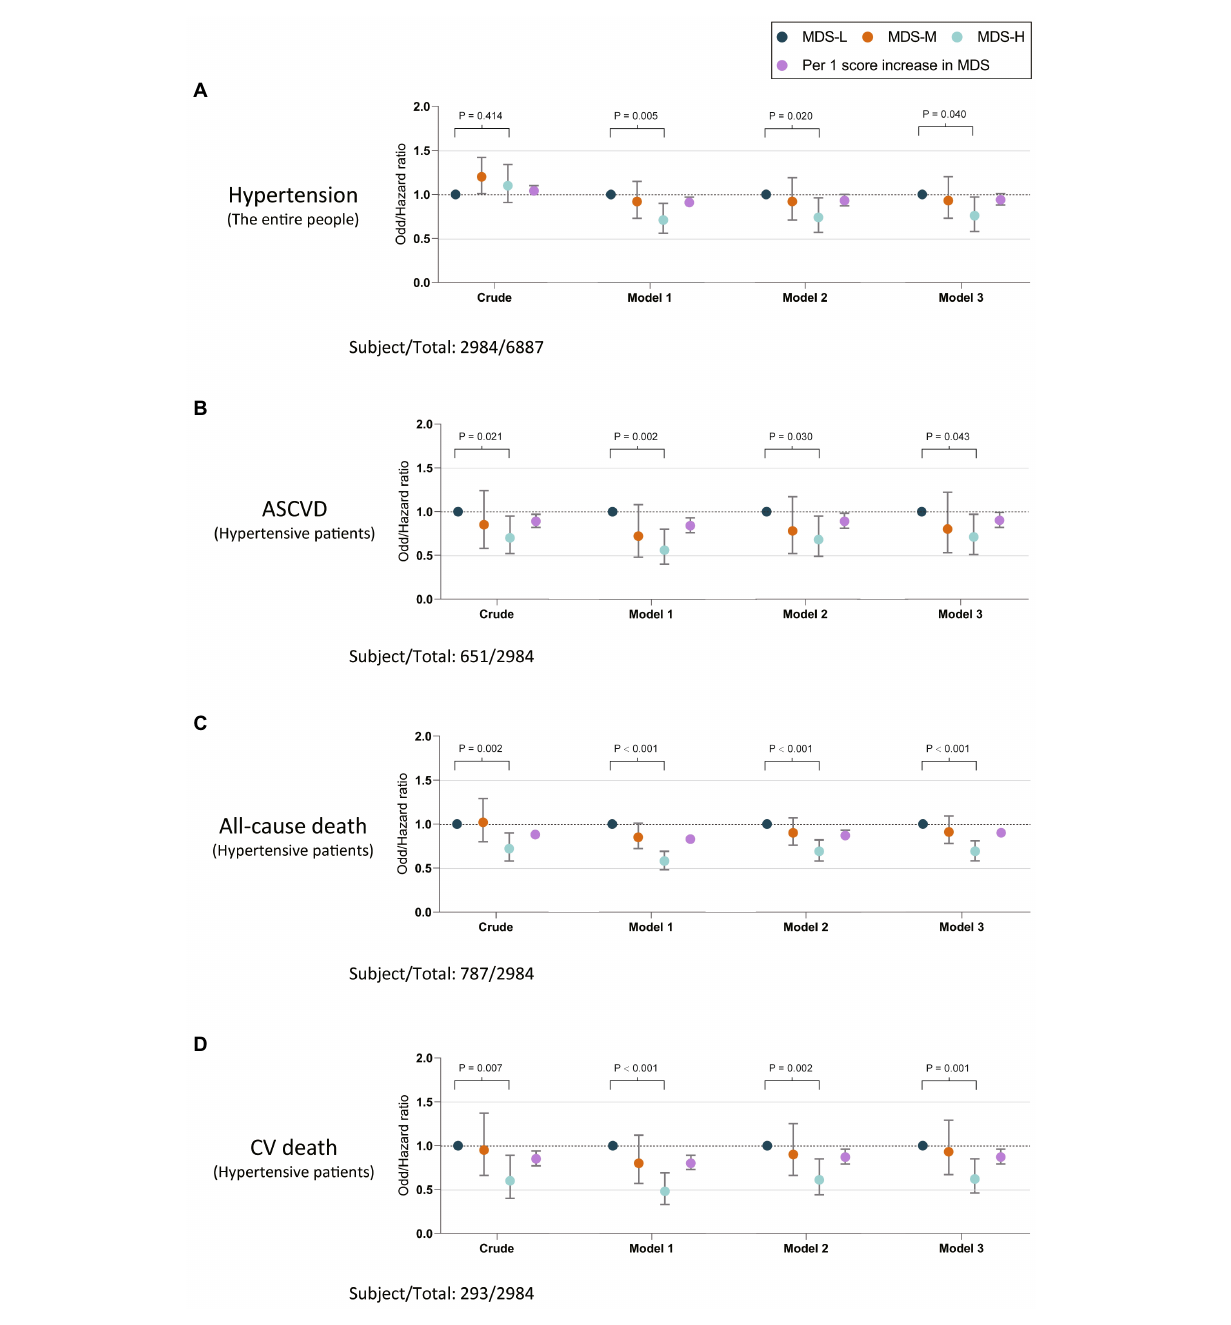
FIGURE 2 Odds/hazard ratios and 95%CI for the associations of MDS with the risk of hypertension in entire participants (A) , and the risk of ASCVD (B) , all-cause death (C) , and CV death (D) . MDS-L, Low MIND score, the MIND diet score < 7.5; MDS-M, Medium MIND score, the MIND diet score ≥ 8 and < 8.5; MDS -H, High MIND score, the MIND diet score ≥ 8.5. ASCVD, atherosclerotic cardiovascular disease; CV, cardiovascular; MIND diet, Mediterranean-DASH Diet Intervention for Neurodegenerative Delay diet; MDS, the MIND diet